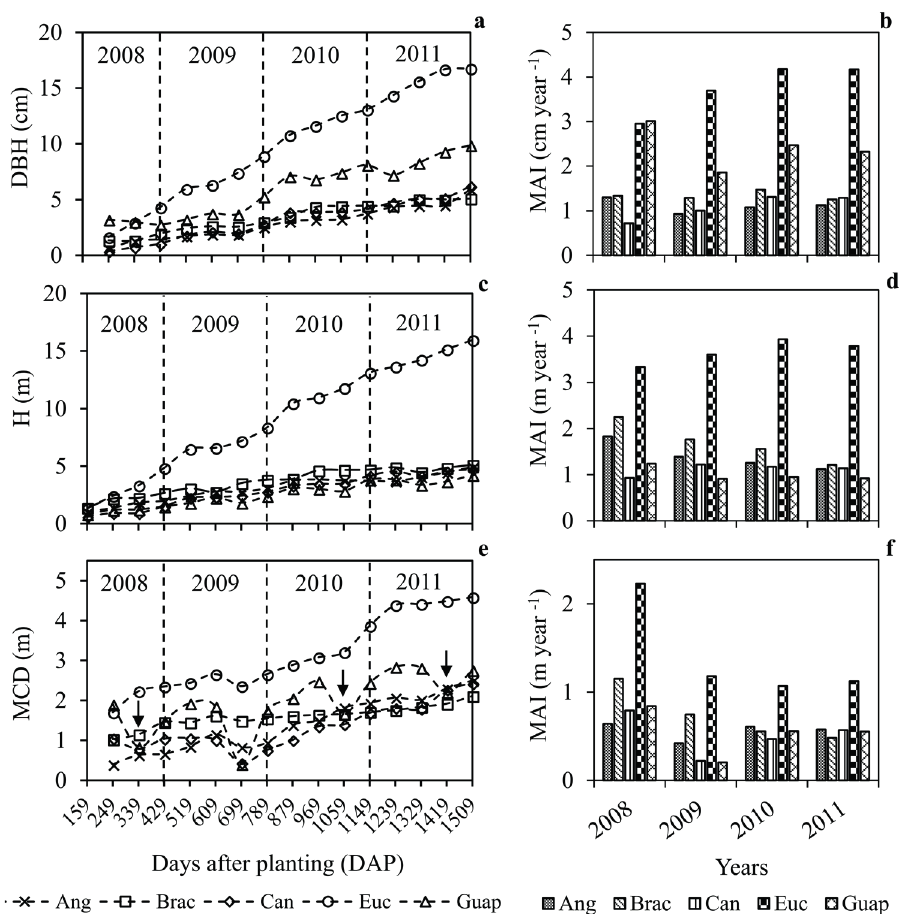
Figure 4 - Growth and mean annual increment (MAI) of diameter at breast height (DBH; a and b ), height (H; c and d ) and mean crown diameter (MCD; e and f ) of tree species angico (Ang), bracatinga (Brac), canafístula (Can), eucalypt (Euc) and guapuruvu (Guap), from 159 to 1509 days after planting in Frederico Westphalen - RS. Vertical arrows indicate damage related to frost.